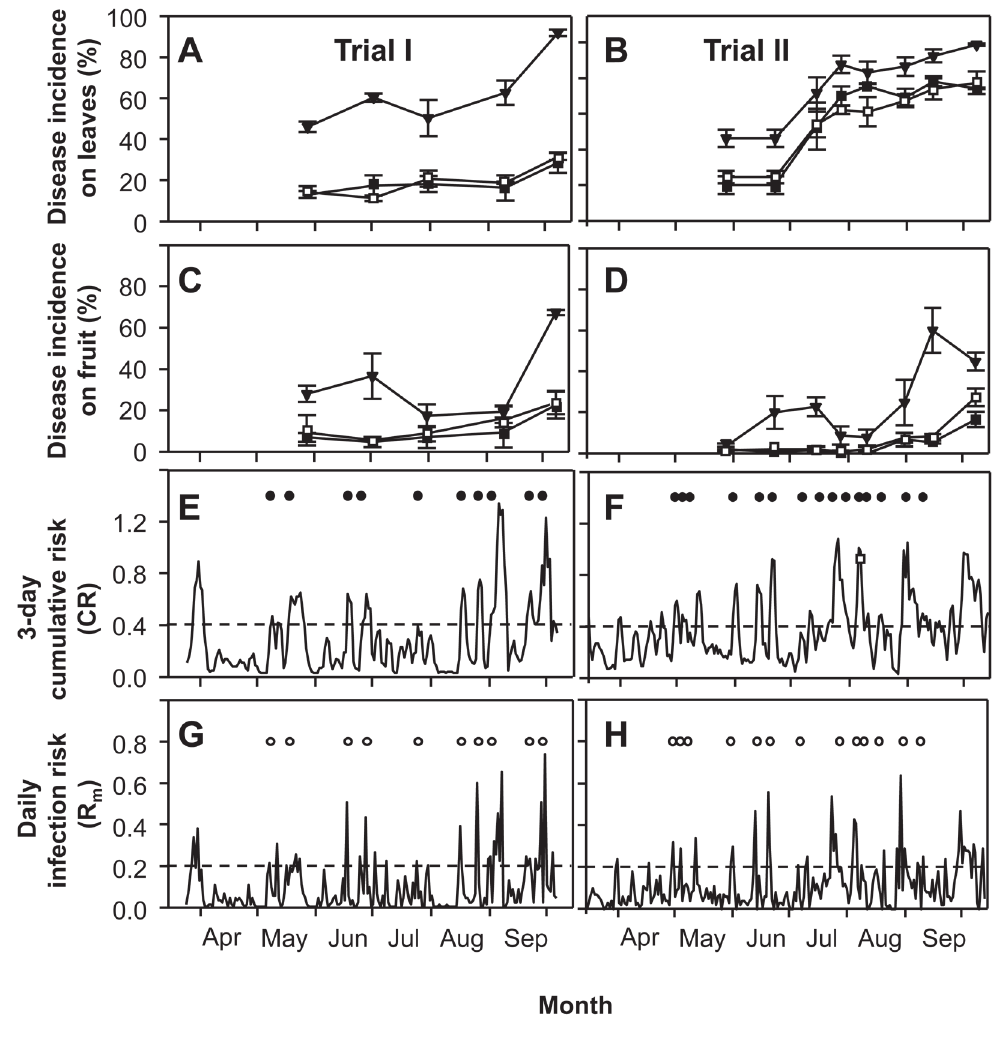
Figure 2. Brown spot disease progress curves on leaves and fruit in relation to the dynamics of the 3-day cumulative infection risk (CR) and daily infection risk (R ) in trials I and II. Treatments corresponded to non-treated control ( ○ ) m and fungicides applied at CR≥0.4 ( ○ ) or R ≥0.2 ( ○ ) (A, B, C and D). Bars represent the standard error of the mean. m Dates of treatments are indicated and corresponded to dates of CR≥0.4 ( ○ ) (E, F) or R ≥0.2 ( ○ ) (G, H). Dashed line m corresponds to action threshold